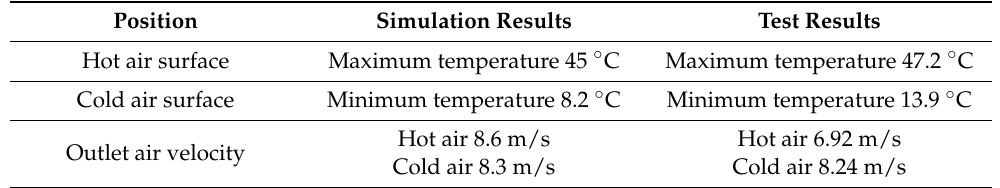
Table 3. Comparison of simulation results and test